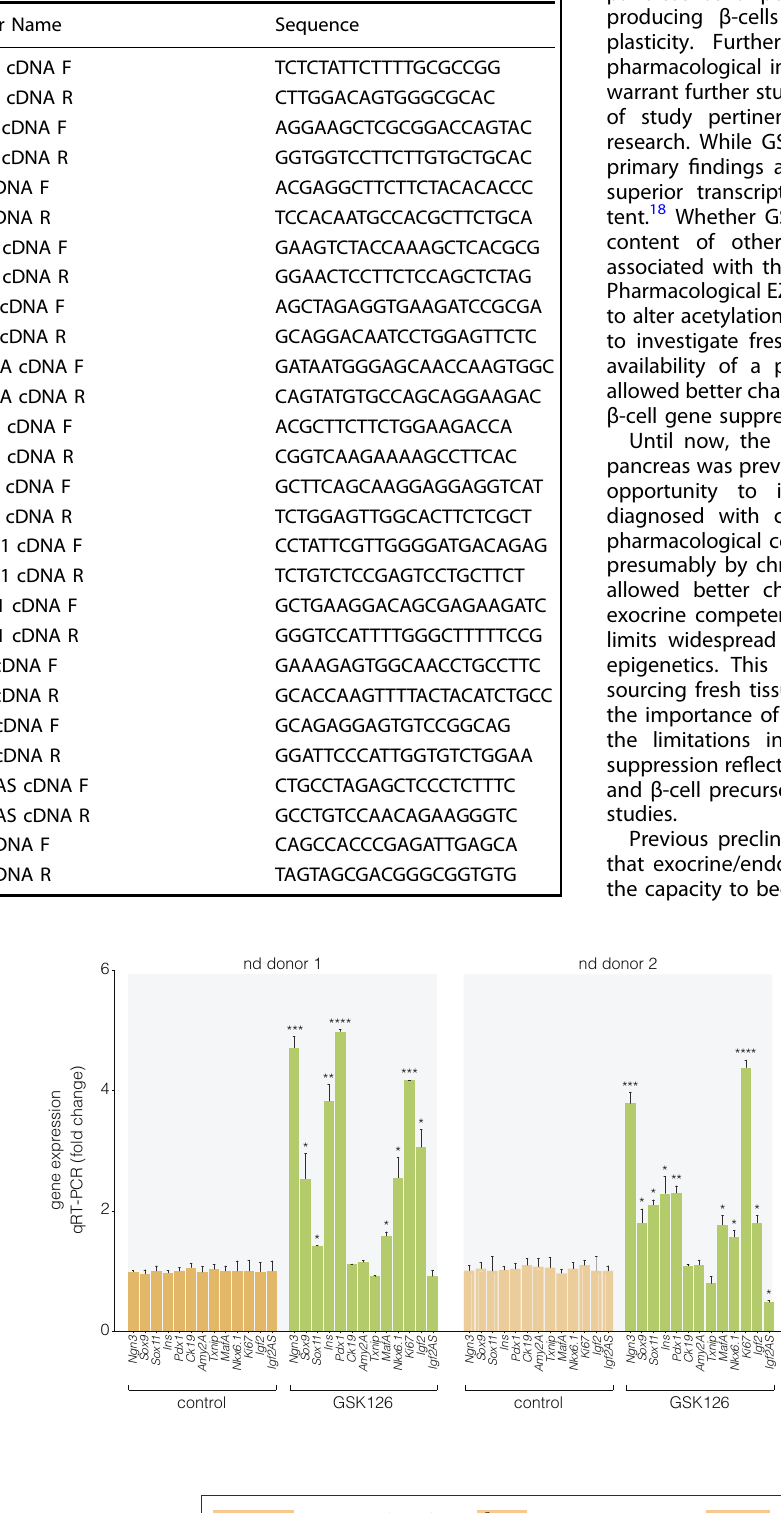
Table 2. Human primer sequences for mRNA expression